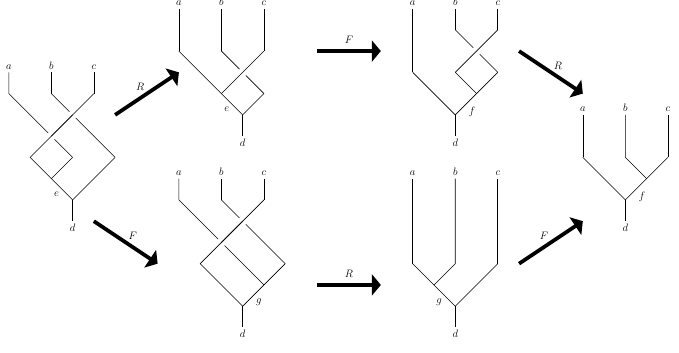
Figure 2 . Hexagon equation w.r.t. the fusion space ( V abc